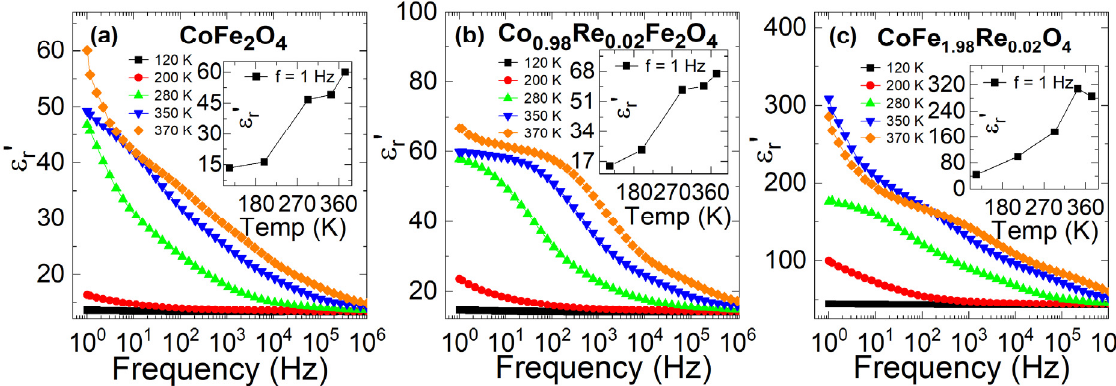
Figure 7. Variation in the dielectric constant of ( a ) CoFe 2 O 4 , ( b ) Co 0.98 Re 0.02 Fe 2 O 4 , and ( c ) CoFe 1.98 Re 0.02 O 4 nanoparticles with different temperatures. The dielectric constant decreases significantly at high frequencies. The dielectric constant increases in Fe-site doping, while it decreases in Co-site doping.